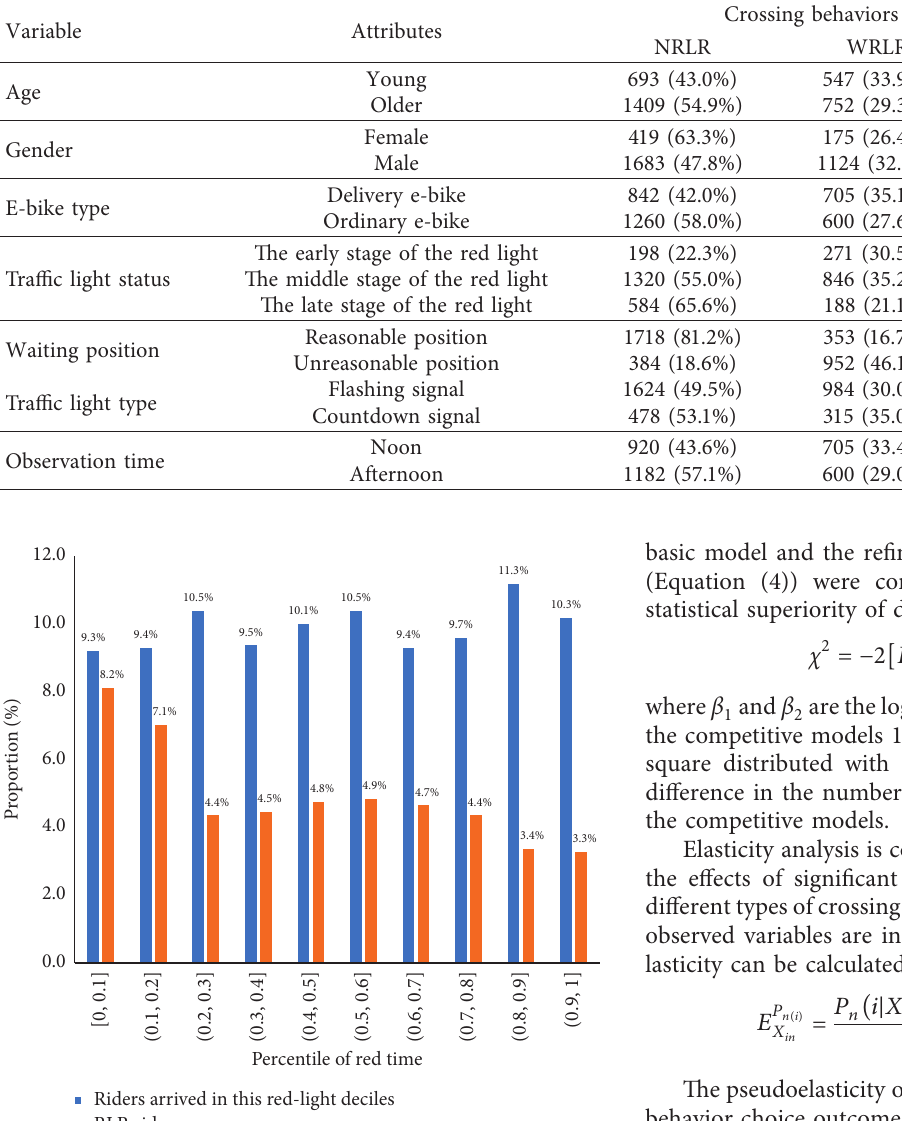
Figure 4: The proportion of riders arriving in each decile of red time and the corresponding riders who running red-light during the entire red-light period (not restricted to certain arrival decile).